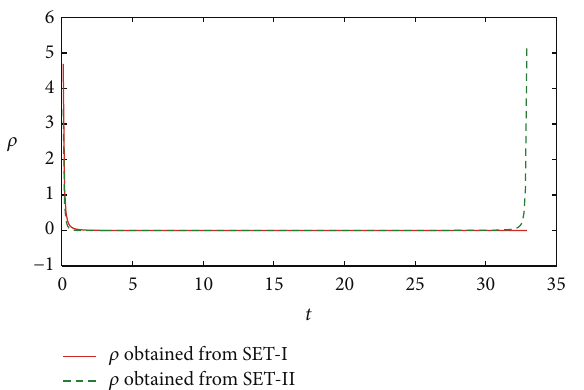
Figure 3: Total pressure 𝑝 versus time 𝑡 for 𝜇 = 0 . 5, 𝜖 0 = 1 / 3, 𝛾 = 1 / 4, 𝛽 = 1 . 5, 𝛼 = 0 . 1, 𝐴 1 = 1, 𝑅 1 = 1, 𝑛 = 1 . 6, and 𝑘 = 0 . 097.